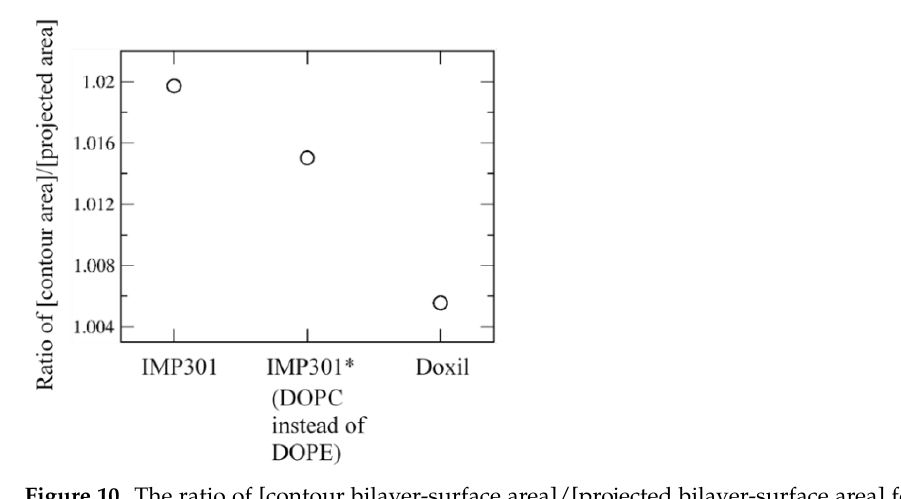
Figure 9. Projected and contour bilayer-surface areas of DOXIL as a function of simulation time.